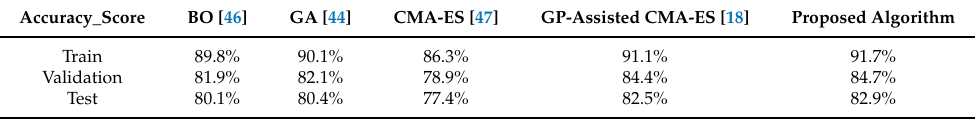
Table 4. Simulated results of all experimental algorithms with 500 spiking neurons on